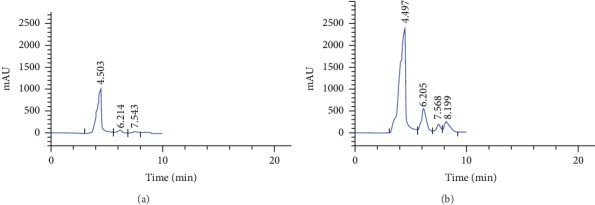
HPLC-RID chromatogram of the fermented extract and GA3 standard (reagent grade). (a) Analysis of GA3 standard solution at 0.100 g.L−1 and (b) fermented extract contents GA3 according the conditions used in the present study.